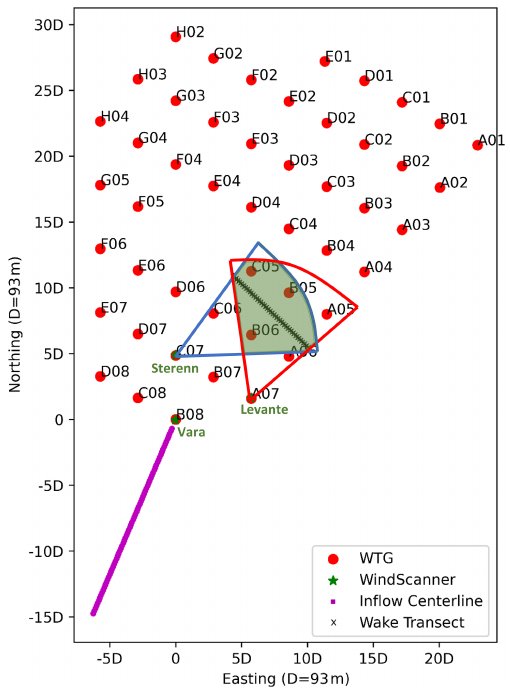
Figure 1. Top-down view of the Lillgrund site and scan areas for inflow and wake measuring lidars installed on turbines B08 “Vara”, A07 “Levante”, and C07 “Sterenn”. Coordinates are relative to the turbine B08 position, spaced in multiples of five rotor diameters. Vara performs PPI sector scans which are reconstructed into wind vectors along the magenta inflow centerline. Sterenn and Levante perform coordinated dual-Doppler complex trajectory scans which provide time and space synchronized measurements at three heights along the wake transect indicated with black crosses. The overlap- ping area between the areas scanned in red by Levante and blue by Sterenn are shaded in green. The positions within the green area which lie off the synchronized wake transect line are resolved through time averaging and applying dual-Doppler retrieval to the 10min averaged wind